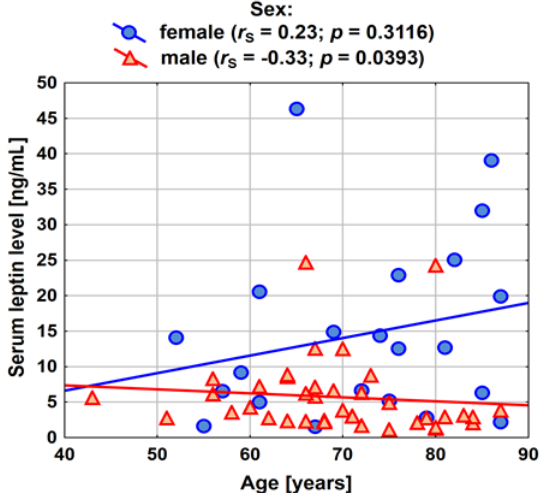
Figure 2. Median values with lower and upper quartiles and minimum and a maximum leptin concentrations for both sexes relative to prescription leptin expression (N = 61). Statistical analysis was performed using the Kruskal-Wallis test and the Mann-Whitney test; p -value < 0.05, * p = 0.0032.